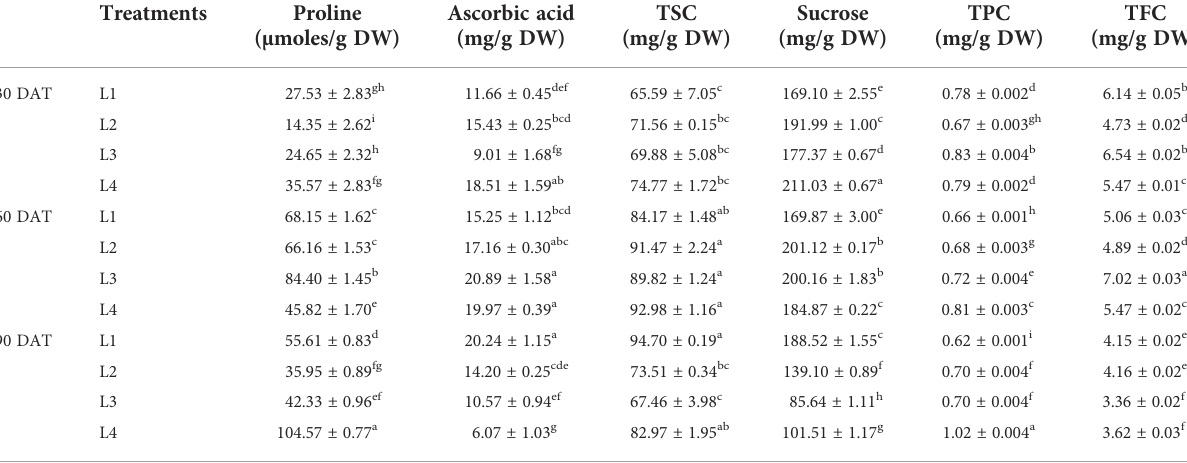
TABLE 1 Effect of LED spectra on proline, ascorbic acid, total soluble carbohydrate (TSC), sucrose, total phenolic content (TPC) and total fl avonoid content (TFC) of hemp seedlings at 30, 60, and 90 DAT.